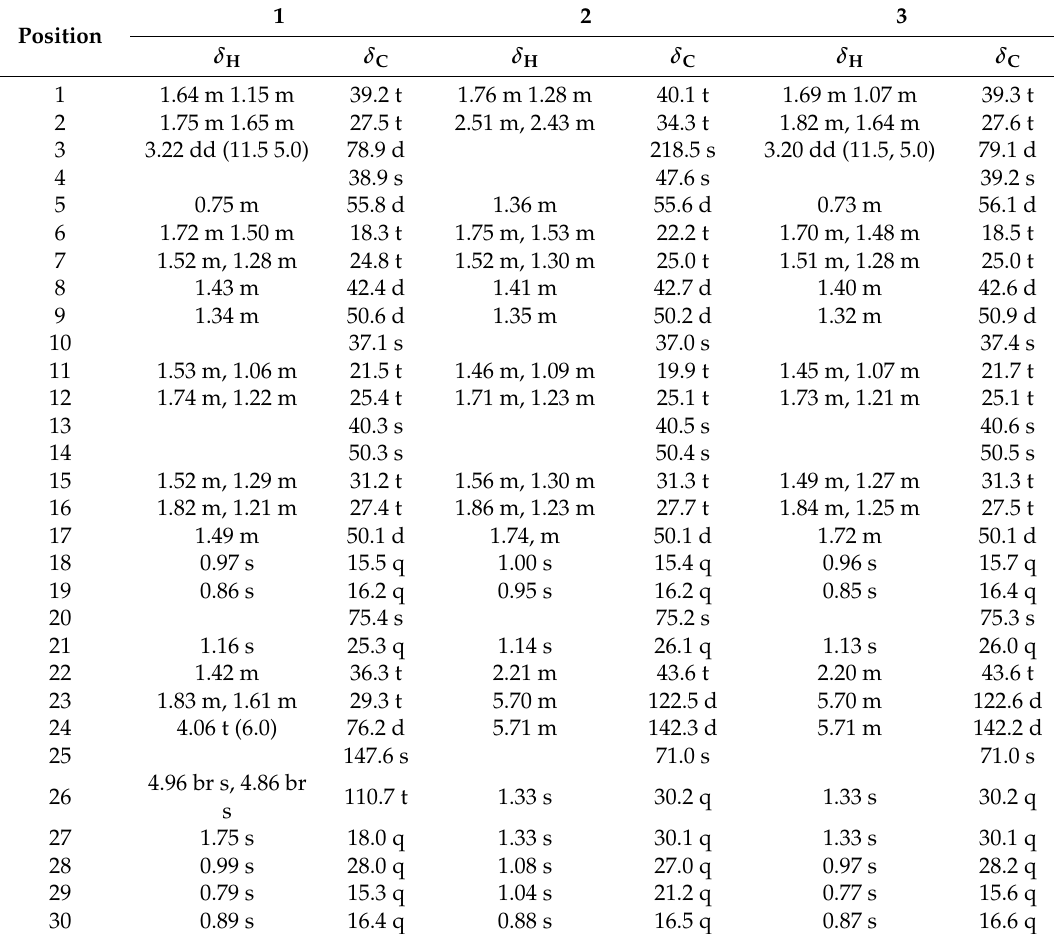
Table 1. 1 H (500 MHz) and 13 C (125 MHz) NMR data for compounds 1 – 3 in CDCl 3 .